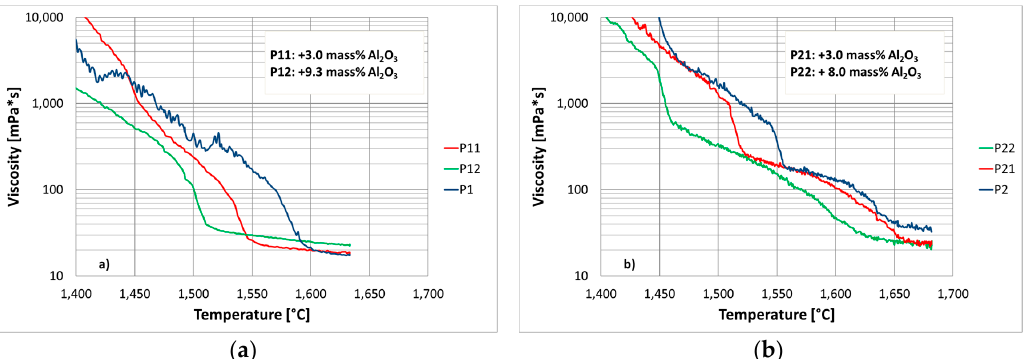
Figure 4. Viscosity of the BOF slag with 2 ( a ) and 8 mass% of MgO ( b ) as a function of temperature for various Al 2 O 3 contents.